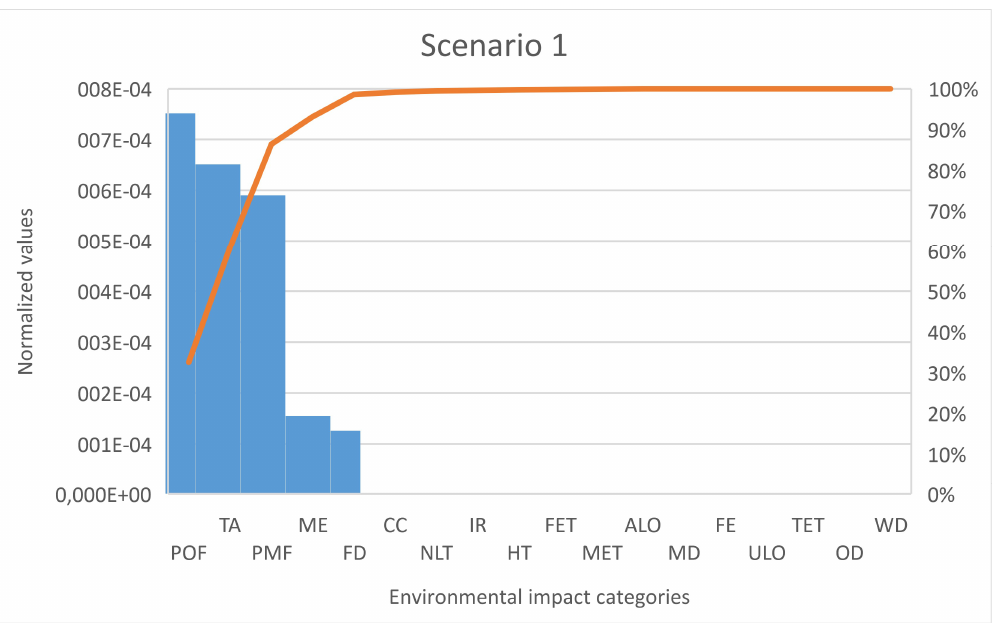
Figure 3. Pareto analysis for scenario 1 (only visible values).